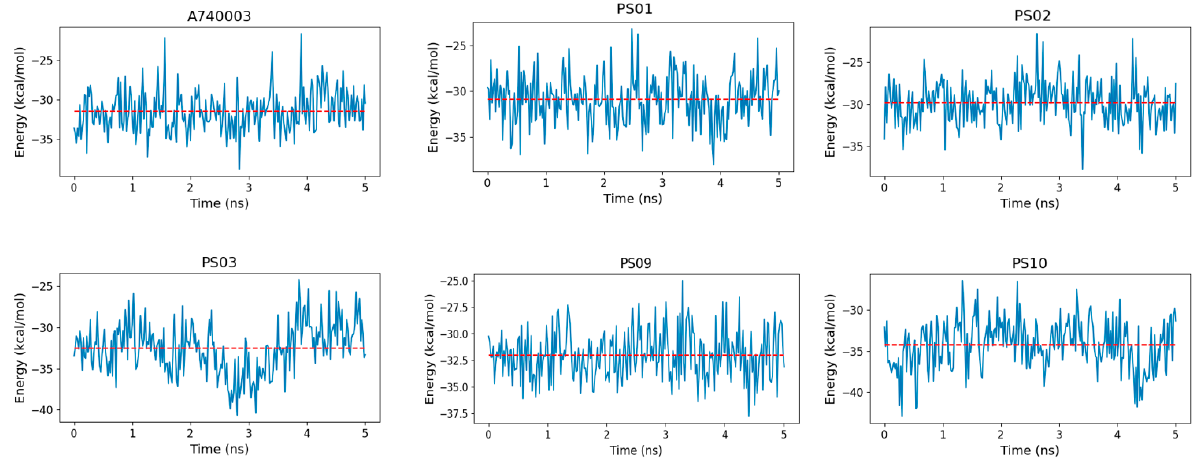
Figure 10. Binding free energy fluctuation of the ligands (A740003, PS01, PS02, PS03, PS09, and PS10) into the P2X7 allosteric binding site during the last 5 ns of simulation for each complex trajectory. The blue line indicates the binding free energy fluctuation, and the dashed red line indicates the binding free energy average.